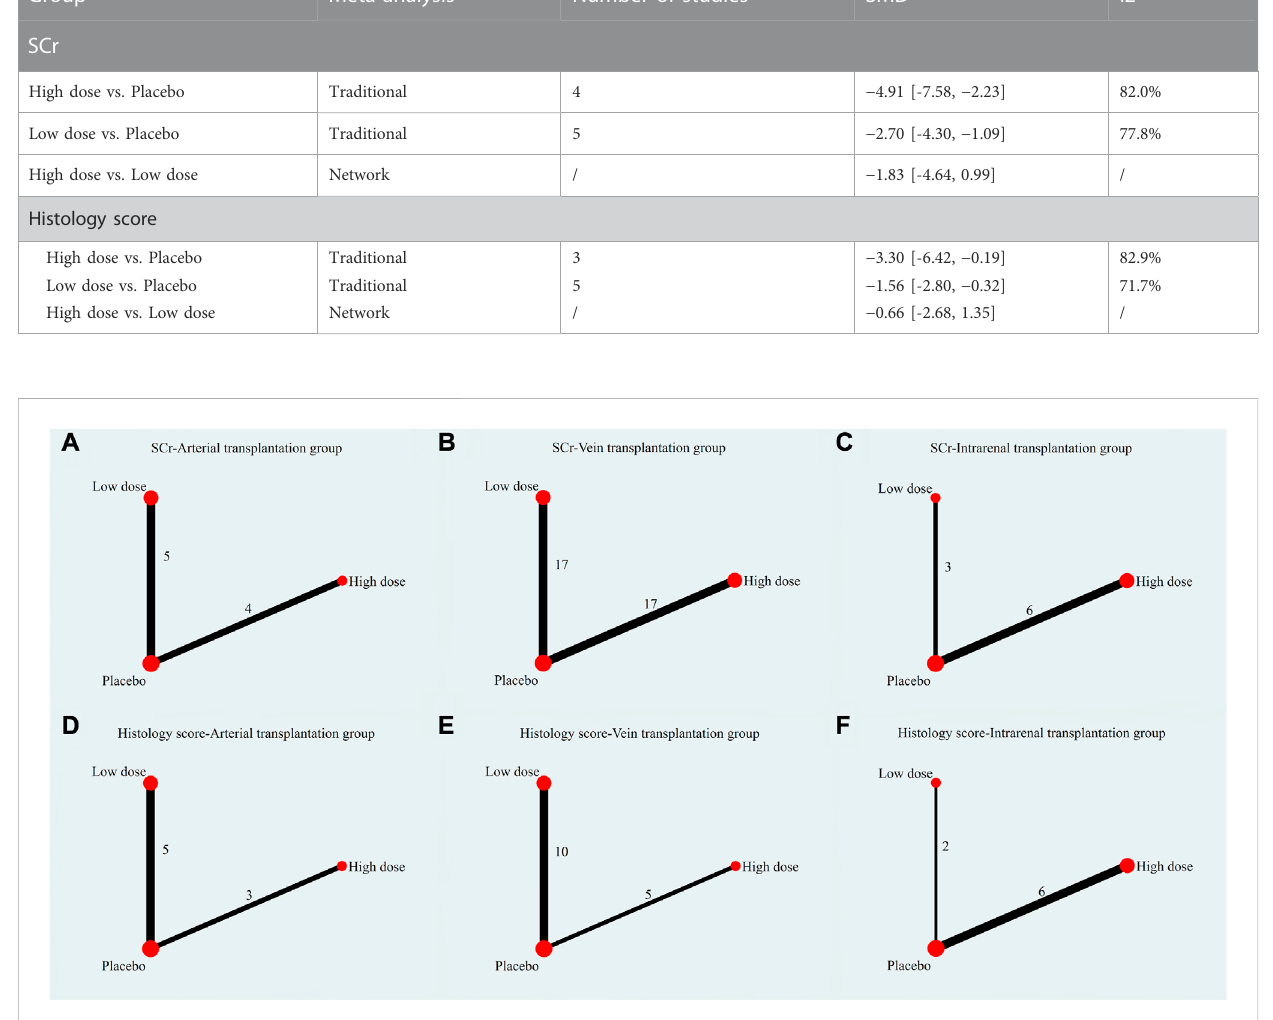
FIGURE 6 Evidence plot of different transplant doses. (A) SCr-Arterial transplantation group. (B) SCr-Vein transplantation group. (C) SCr-Intrarenal transplantation group. (D) Histology score-Arterial transplantation group. (E) Histology score-Vein transplantation group. (F) Histology score-Intrarenal transplantation